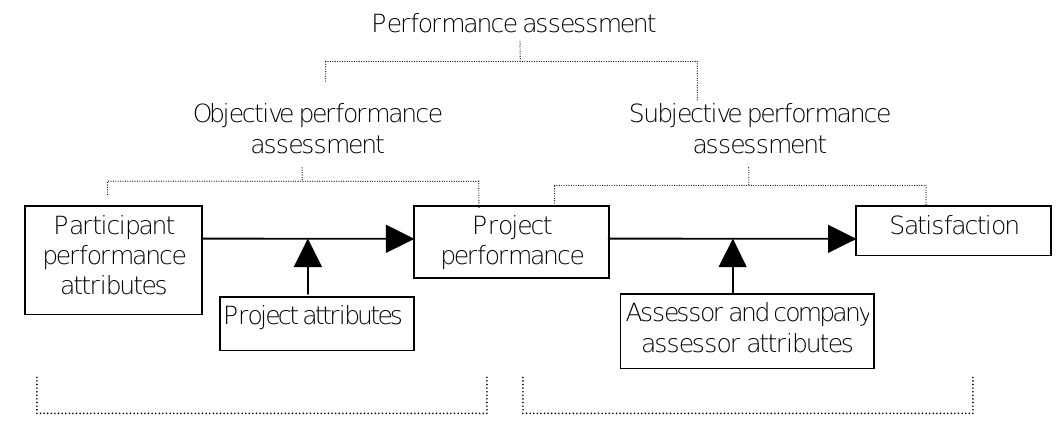
Figure 1: Conceptual performance assessment